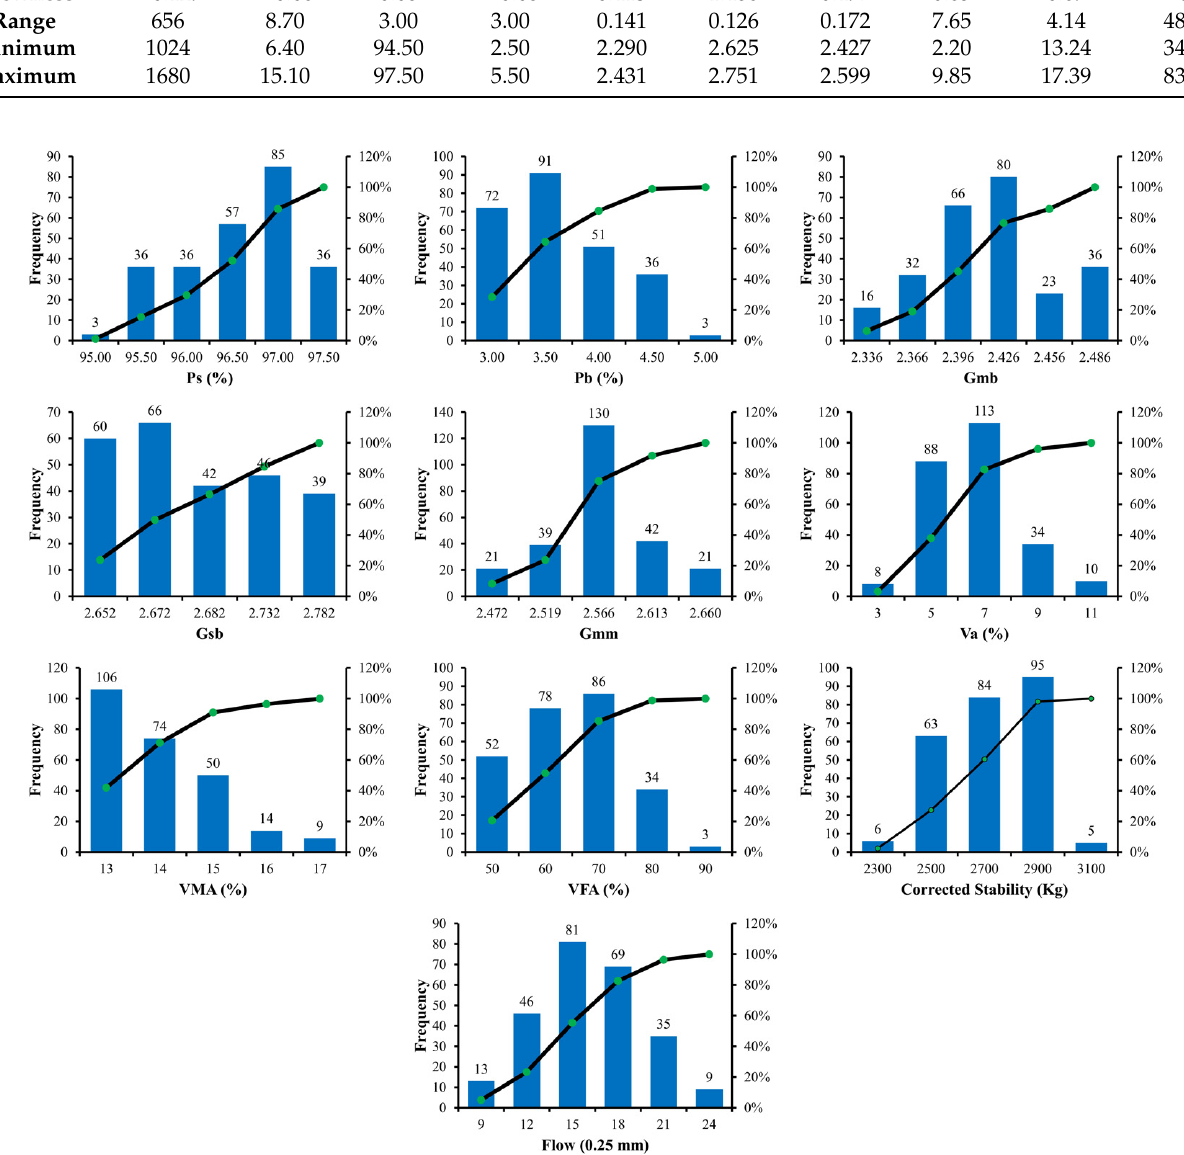
Figure 1. Distribution of input parameters for ABC.